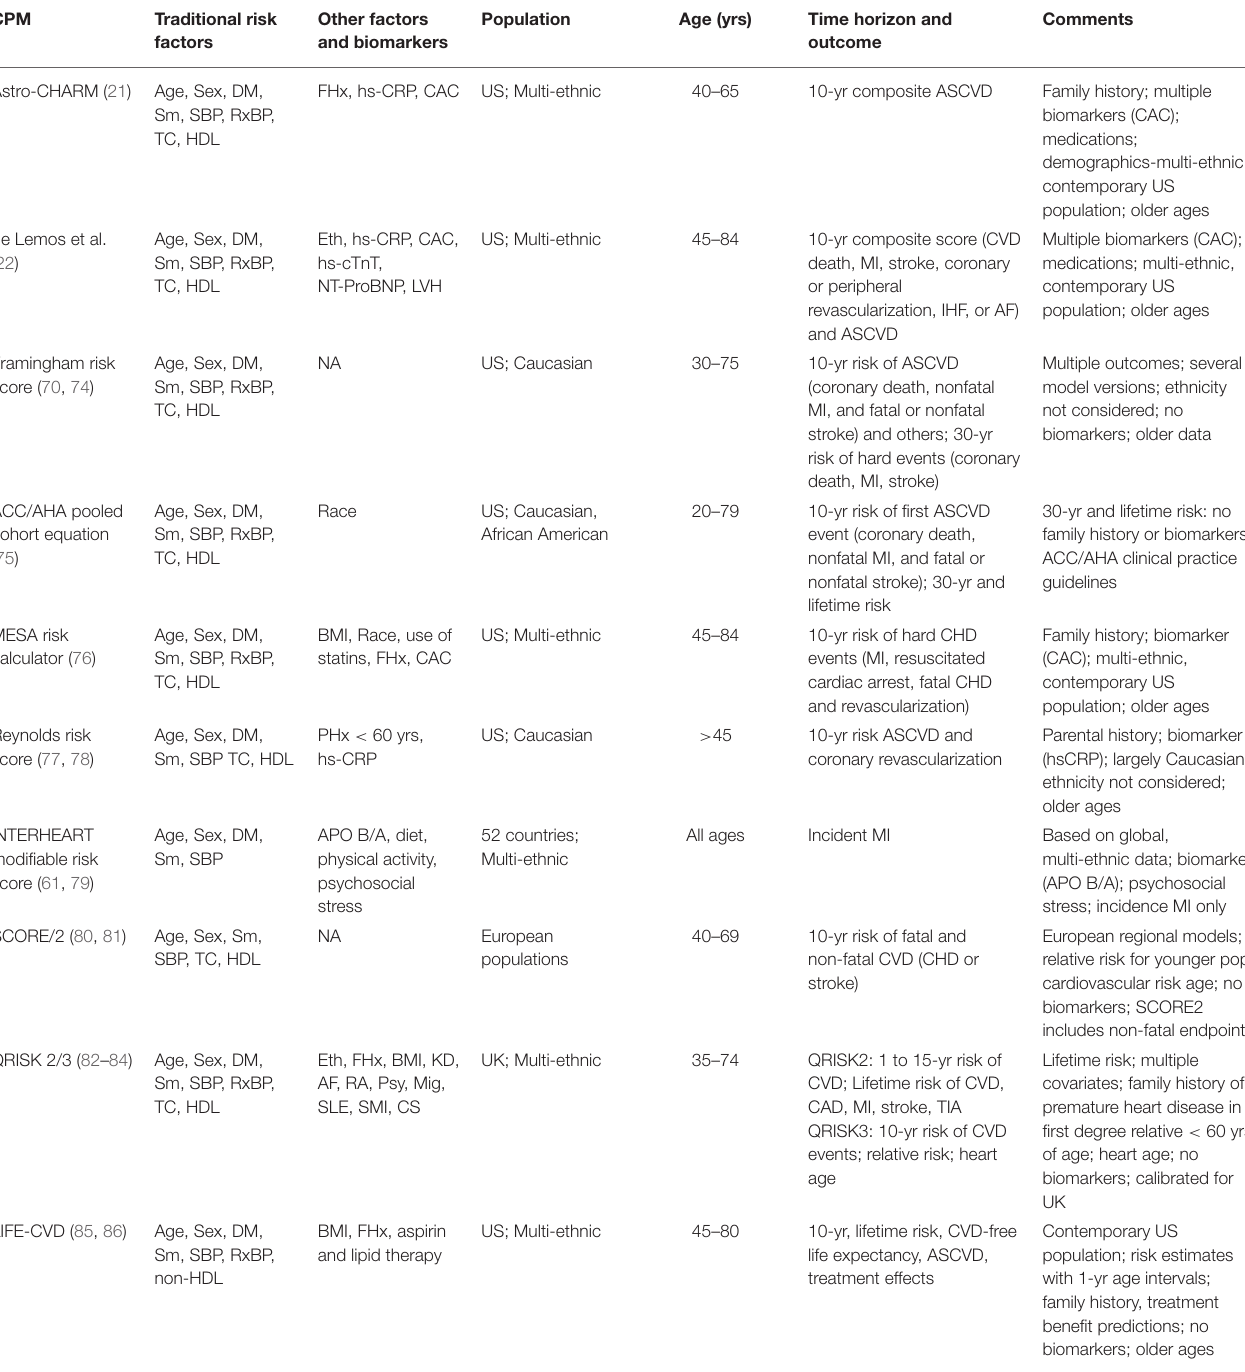
TABLE 3 | Summary of clinical prediction models evaluated for use in NASA radiation-induced cardiovascular disease risk